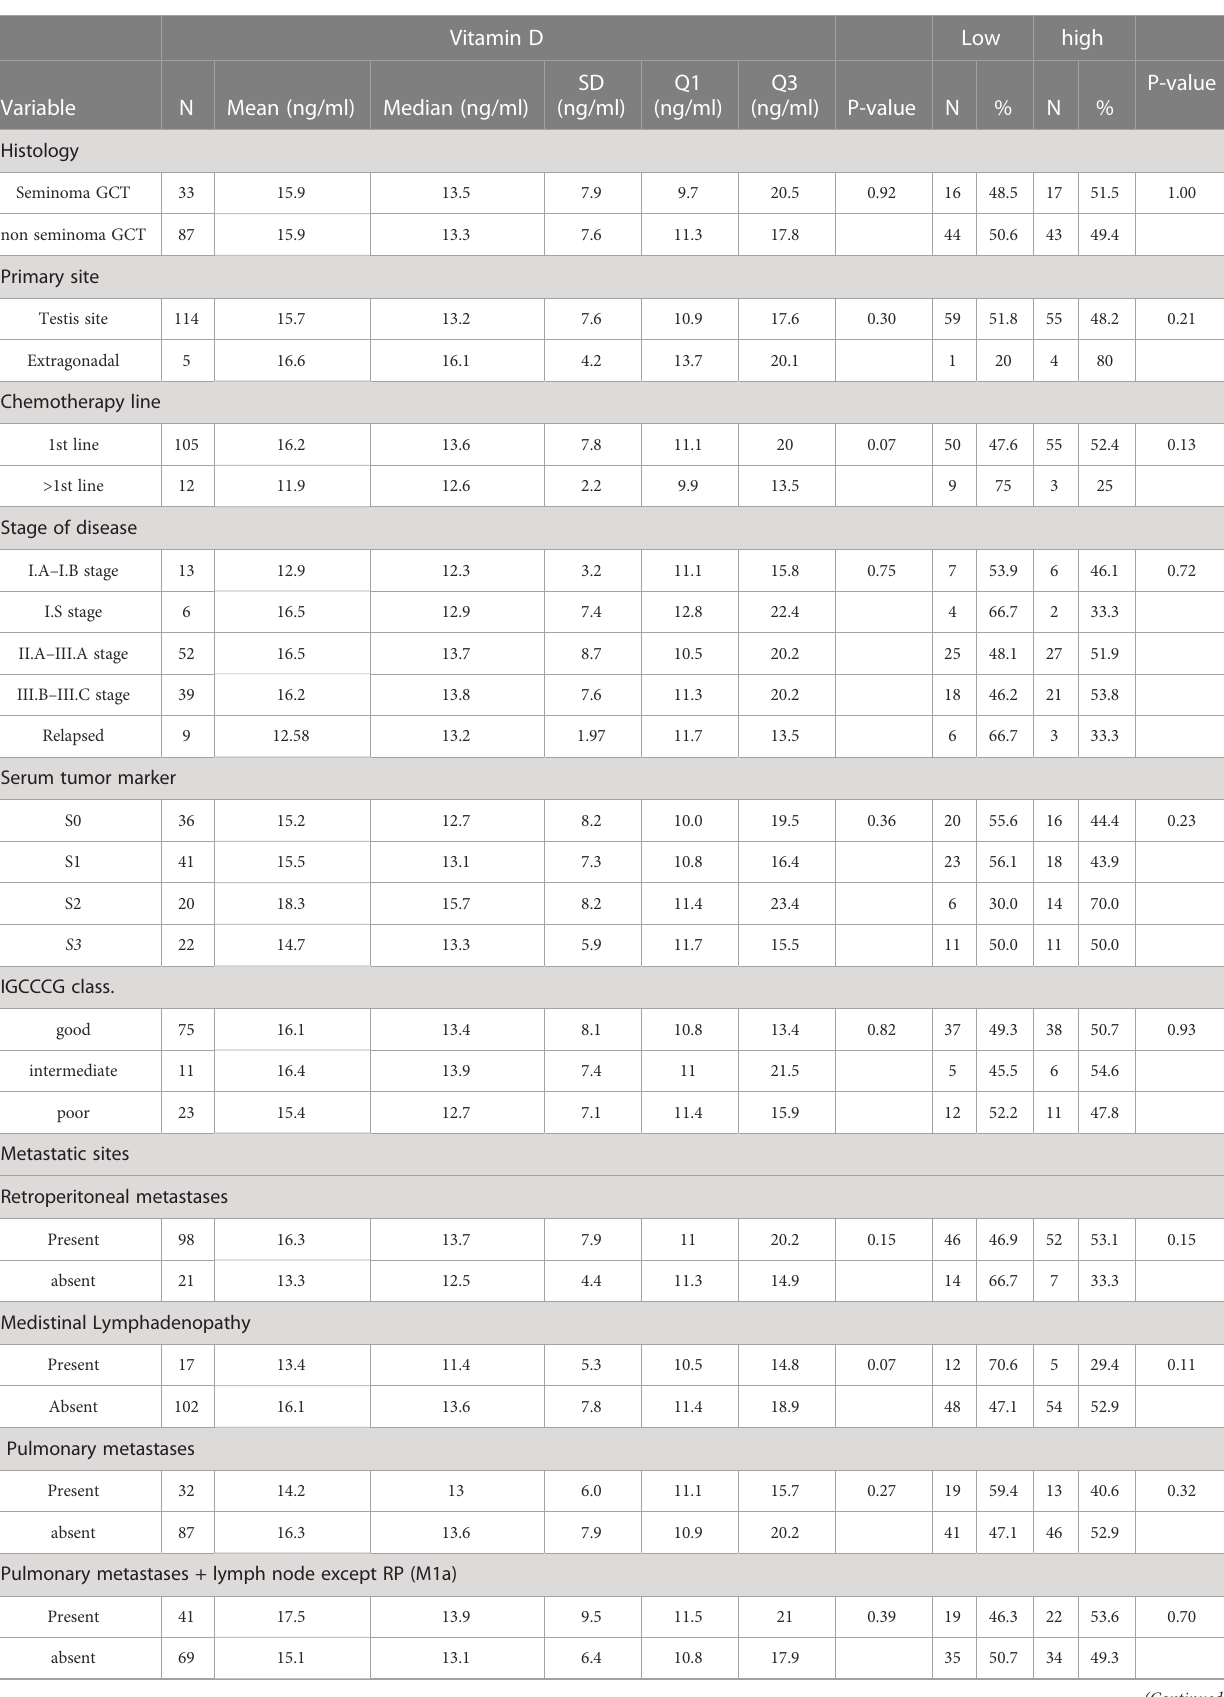
TABLE 2 Vitamin D associations patients/tumor characteristics. Vitamin D